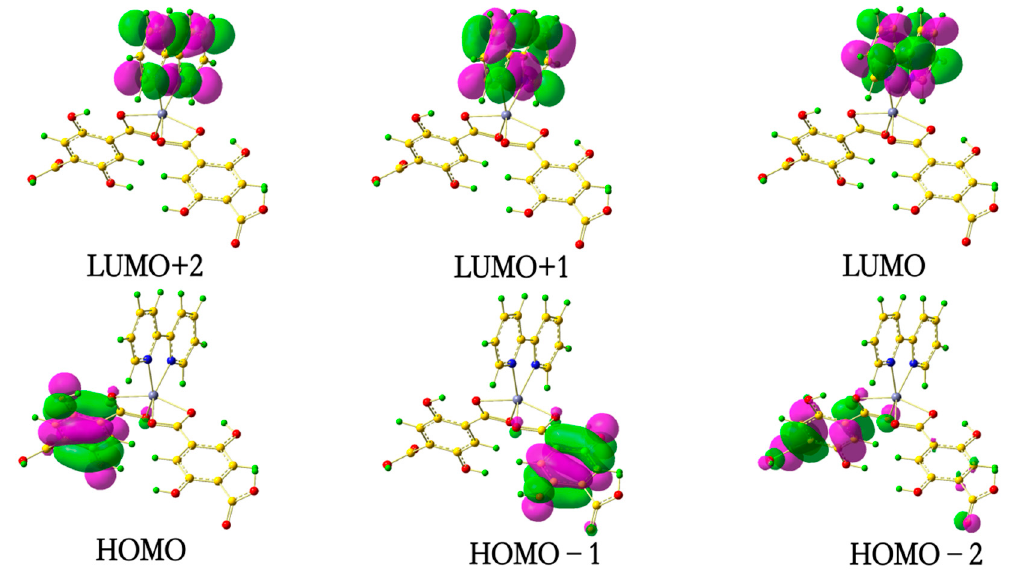
Figure 8. The molecular orbitals of the complex.